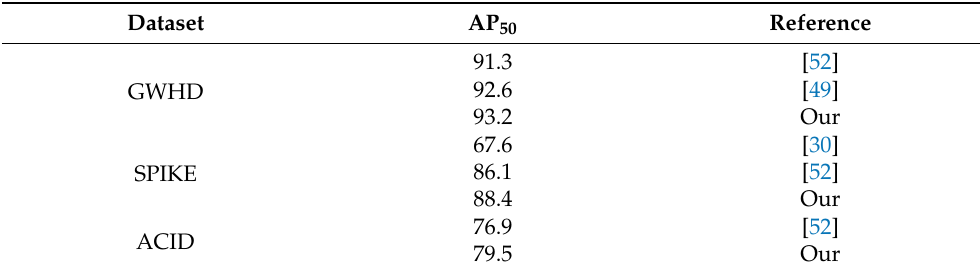
Table 4. Comparison the proposed FR-Transformer on different common wheat head